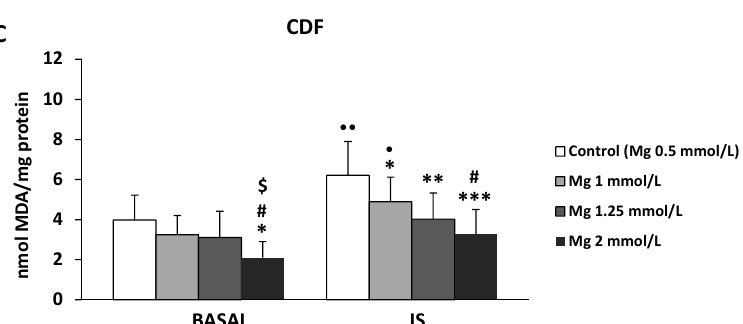
Figure 5. Intracellular malondialdehyde (MDA) levels under basal conditions and in response to